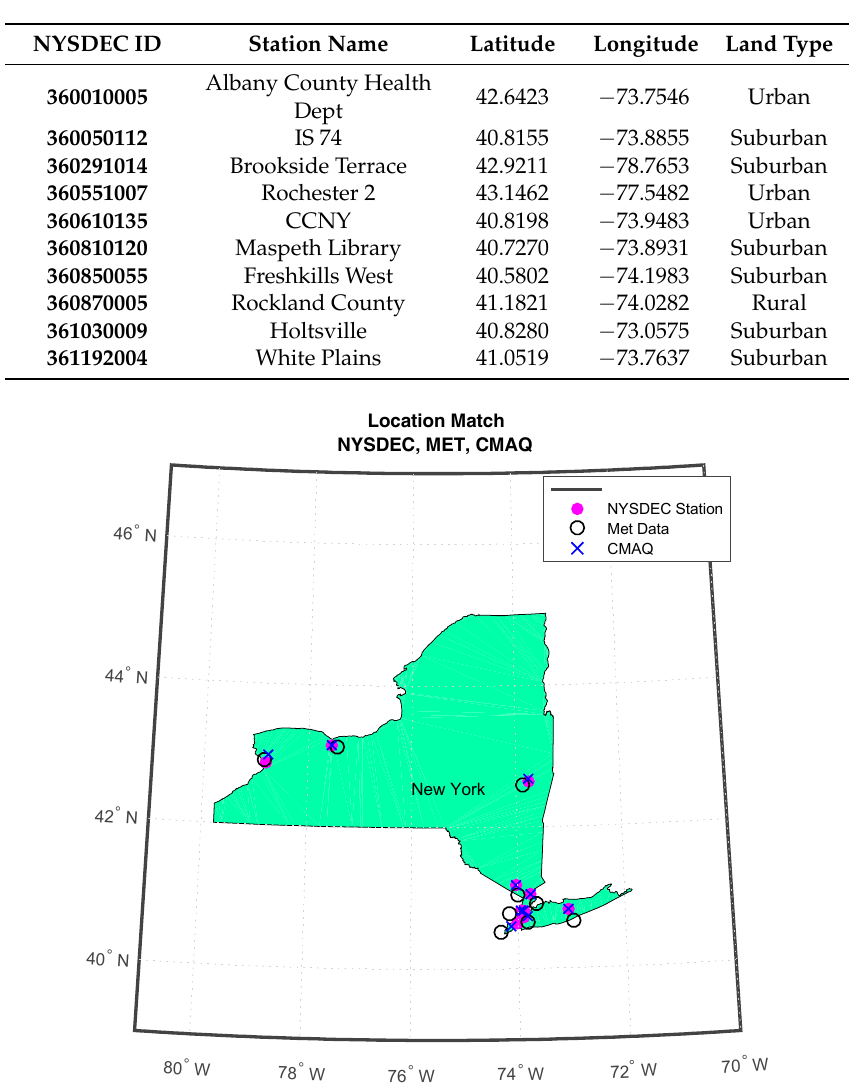
Figure A1. This map shows the proximity of the ground NYSDEC stations to the NARR meteorological data, and the CMAQ forecast data.